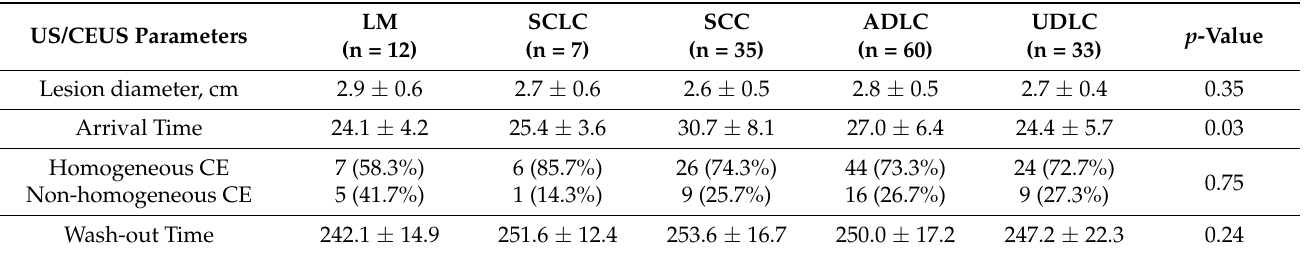
Table 5. Comparison of CEUS parameters between different histopathology subtypes of malignant lesions (LM, lung metastasis; PM, pneumonia; R-CAP, refractory to standard treatment community- acquired pneumonia; SCLC, small cell lung cancer; SCC, squamous cell lung carcinoma; ADLC adenocarcinoma lung cancer; UDLC, undifferentiated lung